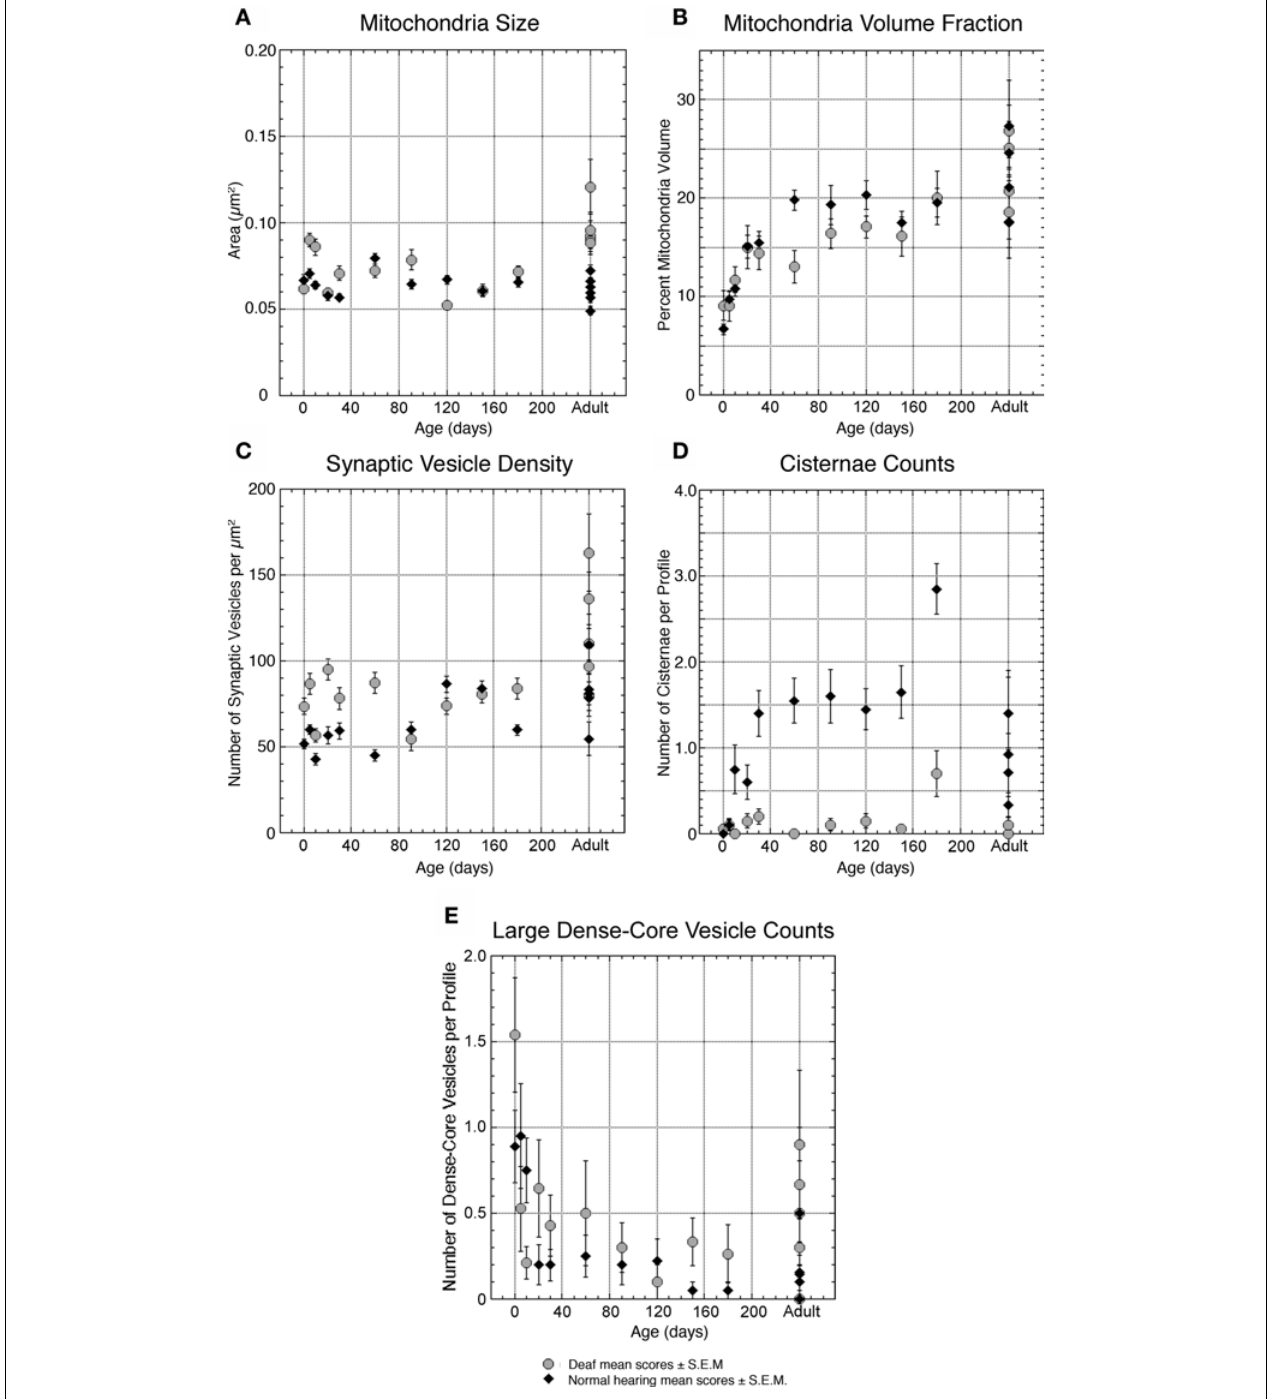
(D) In normal animals, intermembraneous cisternae develop at about 10 days and reach an average of one to two per profi le by 30-days postnatal. Interestingly, deaf animals never develop cisternae. (E) The number of large dense-core vesicles decreases during development in both cohorts with endbulbs of deaf animals exhibiting slightly more dense-core vesicles. Each point represents an average of multiple measures collected from two animals at all time points except adult, where each point represents the average for one animal. The data points in (E) for deaf 60- and 120-day-old animals represent values for only one animal each. Normal data values in (A , B and D) are replotted from Ryugo et al.